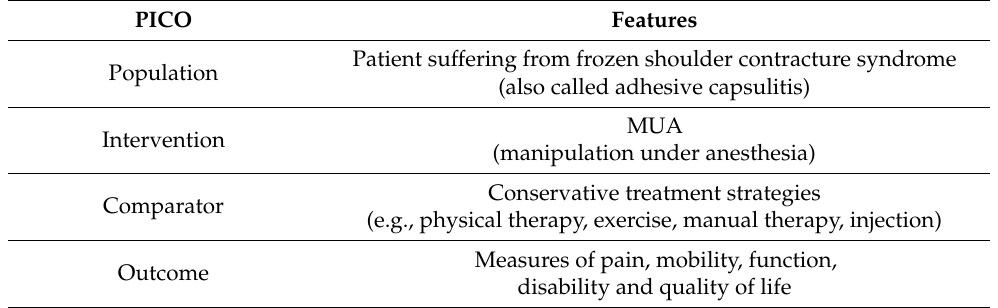
Table 1. PICO components of the systematic